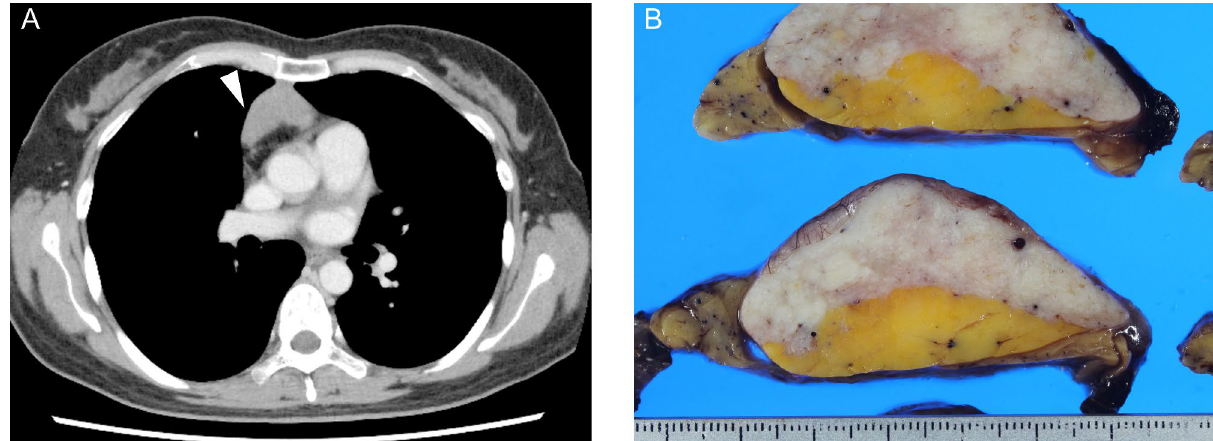
Fig. 1 Clinical images: (A) Chest computed tomography revealed a non-contrast-enhanced mass lesion in the anterior mediastinum. (White arrowhead) Macroscopic images: (B) The cut surface of the material in the anterior mediastinal tumor showed a yellowish lipomatous component and a uniform whitish fibrous